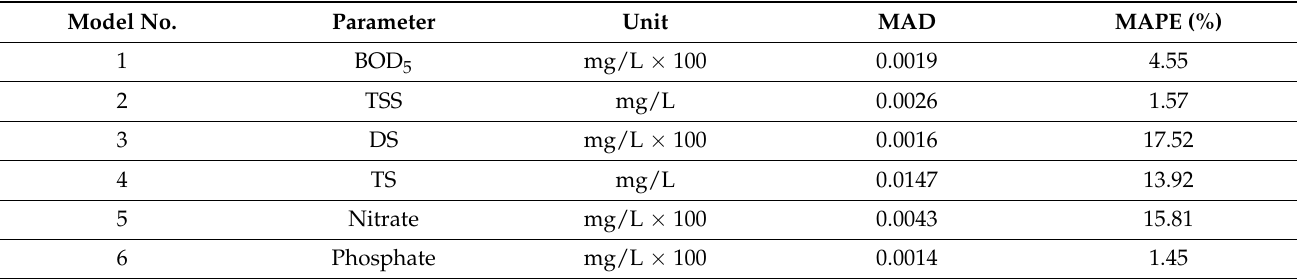
Table 2. Prediction analysis for all models (overall datasets).